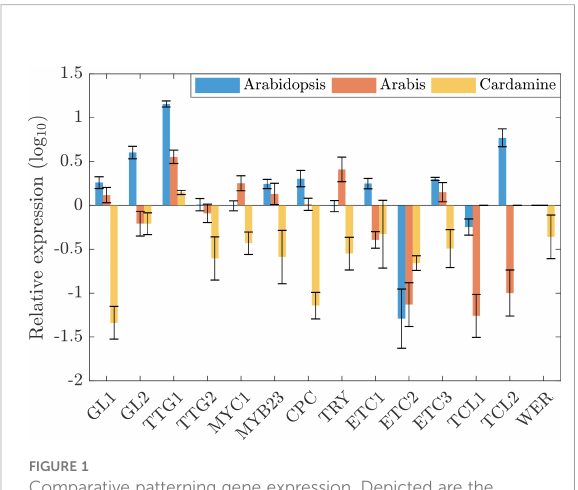
FIGURE 1 Comparative patterning gene expression. Depicted are the expressions and fold changes of 15 patterning genes in A. thaliana (blue), A. alpina (red), and C. hirsuta (yellow) relative to the sum of GL3 and EGL3 in the respective